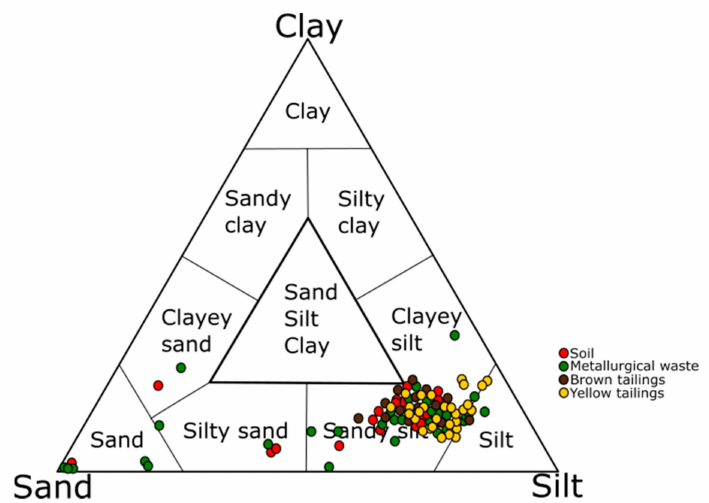
Figure 6. The grain size analysis of different anthropogenic units identified at Plombi è res (modified after Sheppard, 1954